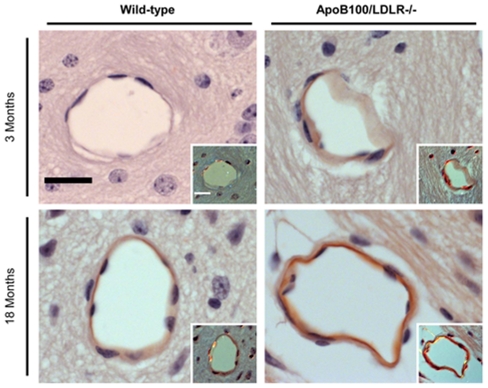
β-amyloidosis in the cerebral vessels of young and aged wild-type and transgenic mice.Congo red staining of coronal sections from each of the age/genotype different groups (1.62 mm from bregma). β-amyloid deposition can be seen in a vessel wall viewed under regular and polarized light (insets); note the apple-green birefringence specific to amyloid. Scale bars: 11 µm.